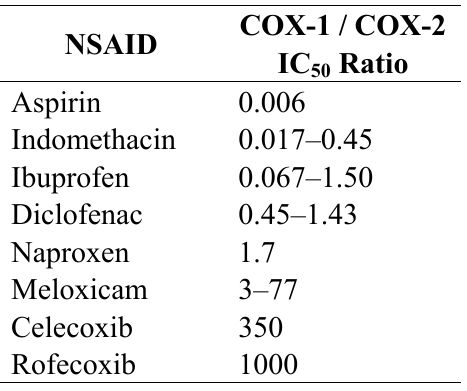
Table 1. COX-2 selectivity of common NSAIDs. A higher ratio value indicates electivity or COX-2. Table modified from